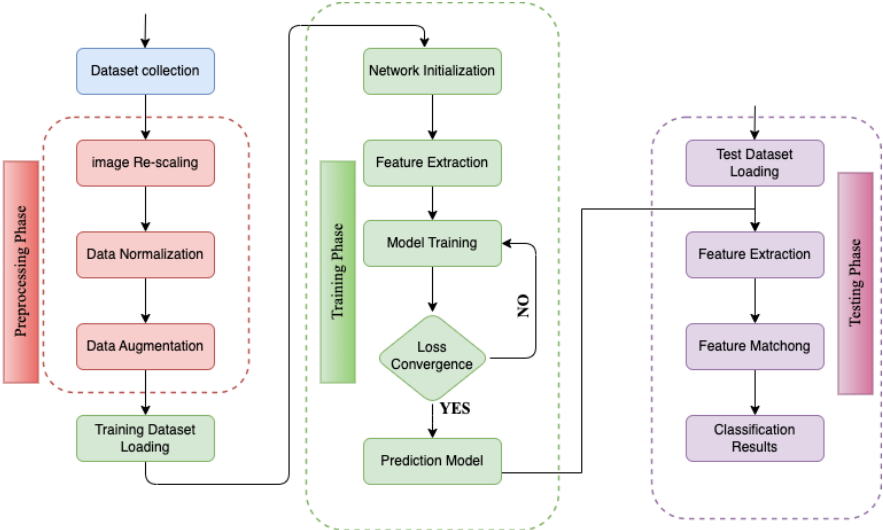
Figure 1. Workflow of the proposed